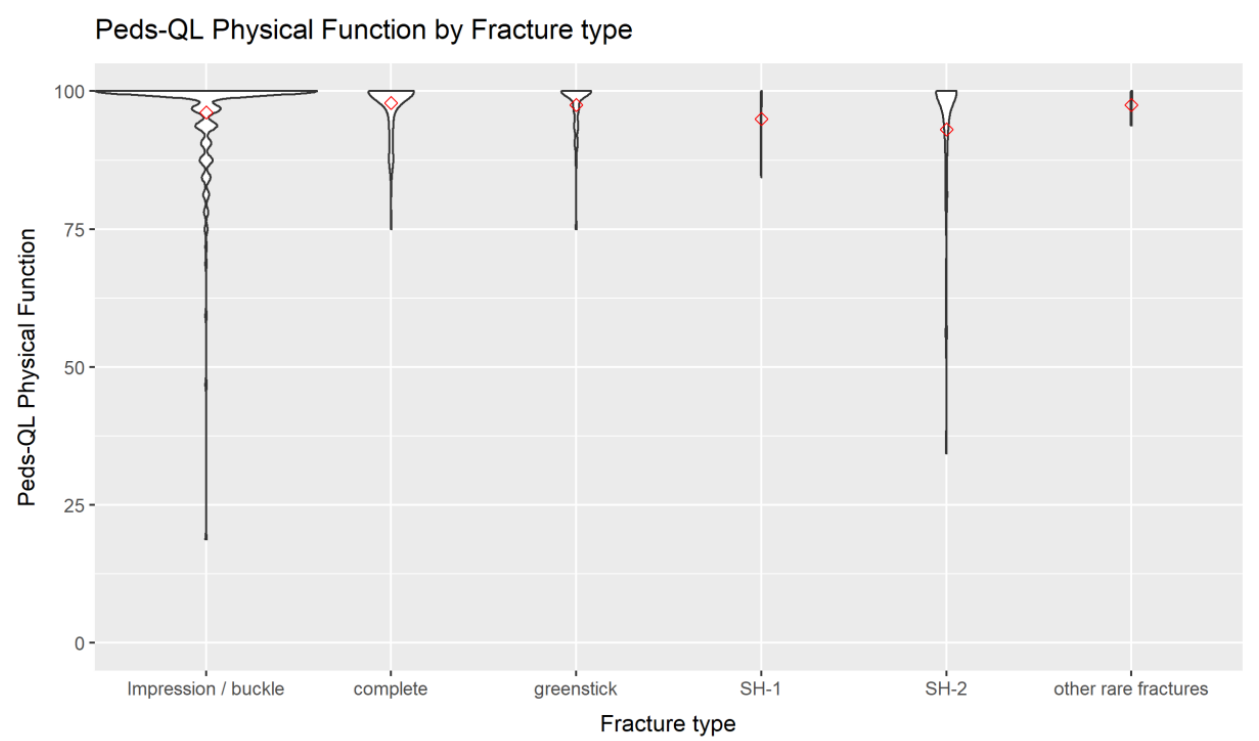
Figure 2. The primary outcome Quick-DASH at follow-up by fracture type of the radius. Since there were considerable ceiling effects, we used violin plots for the graphical presentation. Please see the methods section for a description of the violin plots.